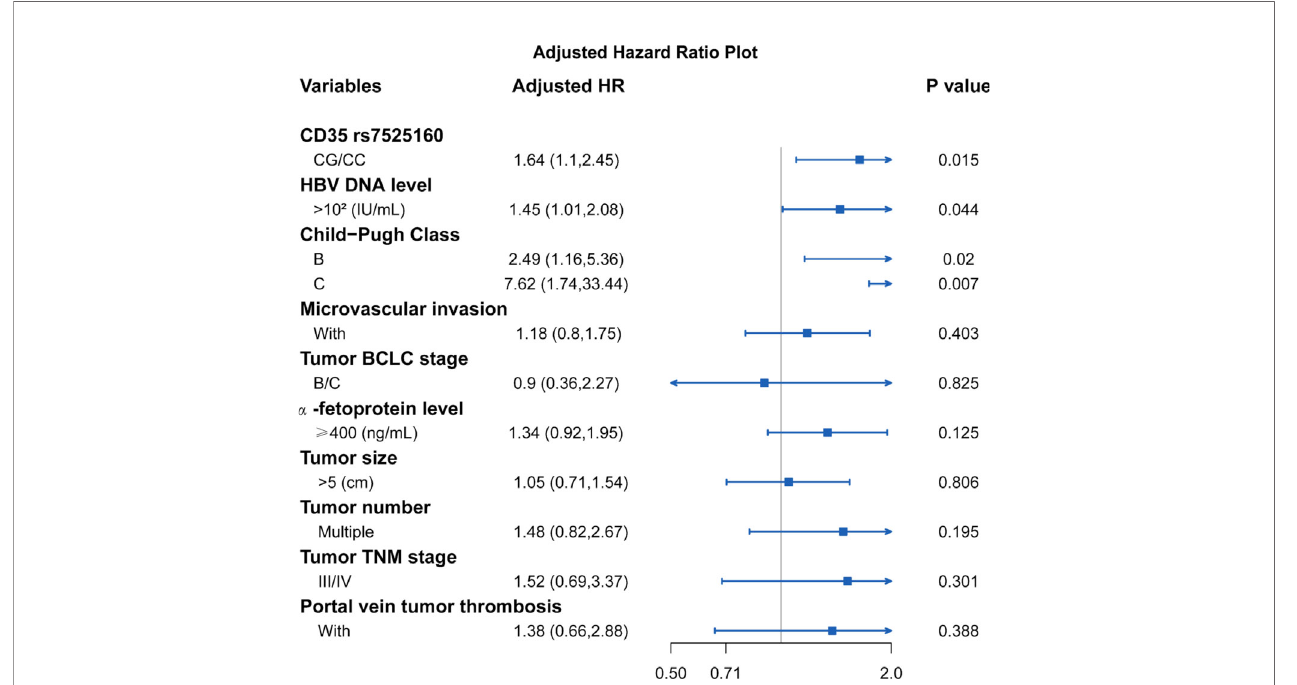
FIGURE 2 | Cox analysis of potential factors for recurrence analysis in patients with resected